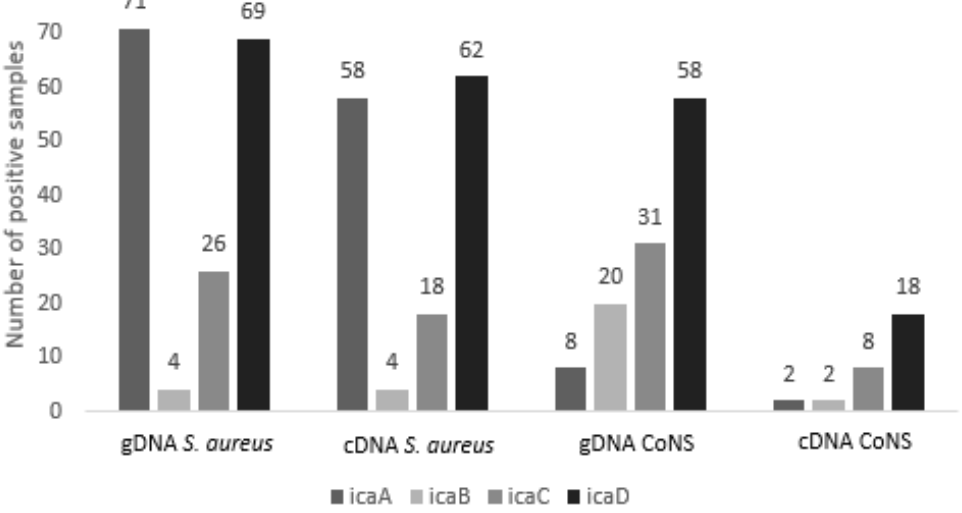
Figure 1. Comparison of the detection of genes of the ica ADBC operon by conventional PCR (genomic DNA, gDNA) and expression analysis by RT-qPCR (complementary DNA, cDNA). Table 1. Distribution of detection (gDNA) and expression (cDNA) of genes involved in biofilm formation according to Staphylococcus species.